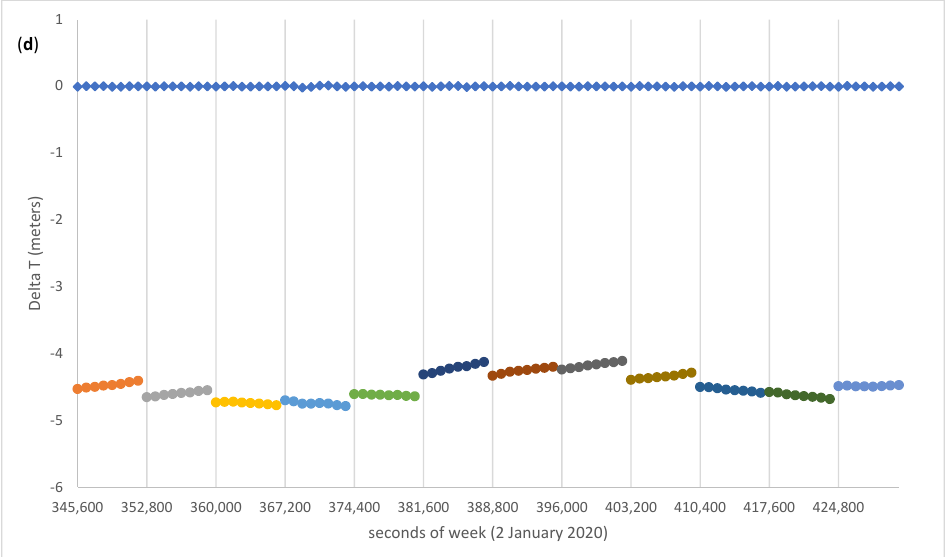
Figure 4. Pre-fit (dots, different colors for different ephemeris blocks) and post-fit (diamonds) residuals of ( a ) X, ( b ) Y, ( c ) Z, and ( d ) T for E01.